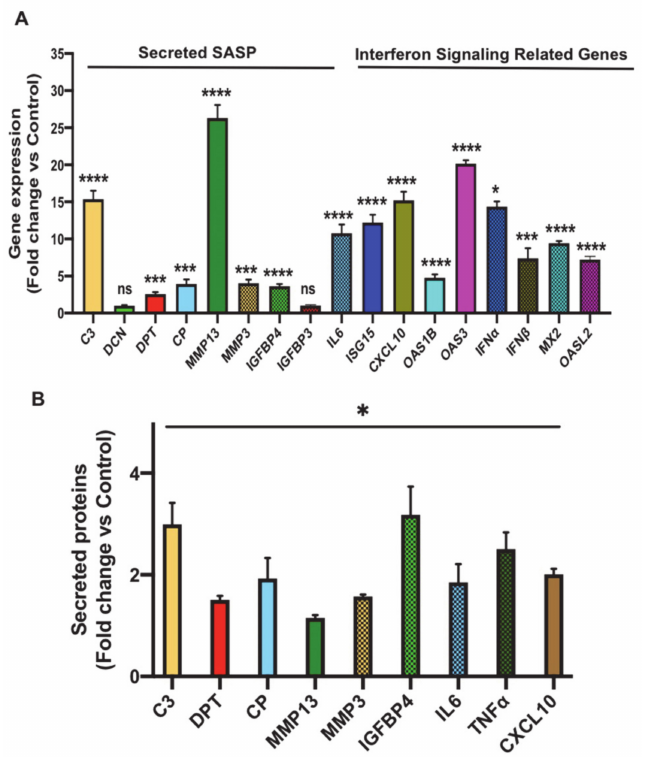
Figure 4. Validation of expression and/or secretion of the most differentially upregulated SASP and interferon/STAT signaling related genes that were identified in the transcriptomics analysis of senescent preadipocytes. ( A ) Gene expression analysis of the most significantly upregulated putative SASP molecules in senescent 3T3-L1 preadipocytes (Day 7) compared to untreated control by real- time quantitative polymerase chain reaction (qPCR). Results (fold change vs. control) are presented as means ± SEM from three independent experiments. * p ≤ 0.05, *** p ≤ 0.001, **** p ≤ 0.0001 (Student’s t-test). ( B ) Graph represents data for ImageJ quantification of the intensity of the signal of the indicated secreted molecule in conditioned media of senescent preadipocytes compared to untreated cells. Data are means ± SEM from 3 independent experiments. * p ≤ 0.05 (Student’s